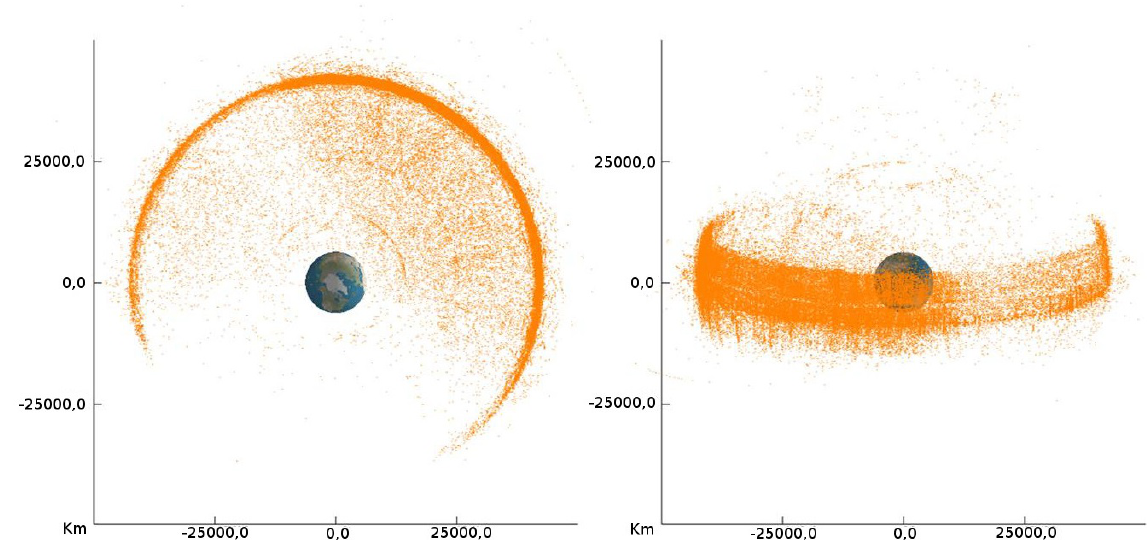
Figure 12. A sample of distribution of space debris objects measured by ISON in Jan–Feb 2017.